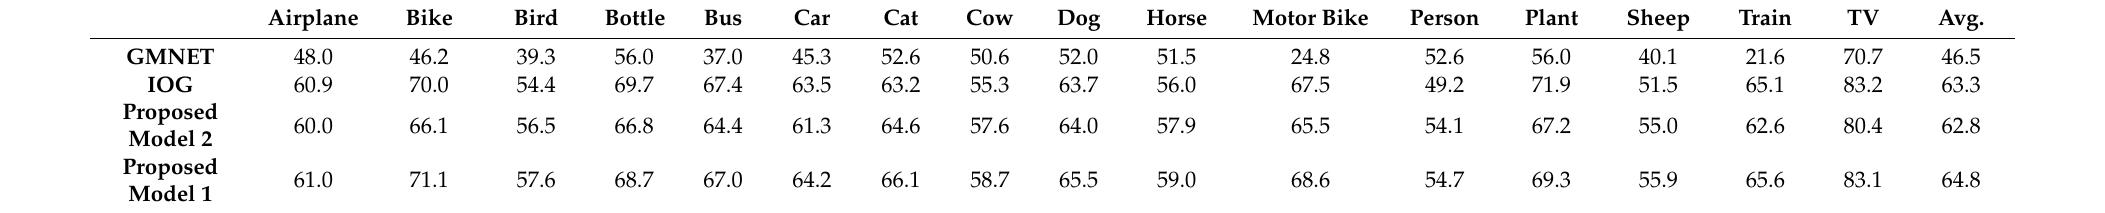
Table 8. The IOU accuracy of the part segmentation for each object